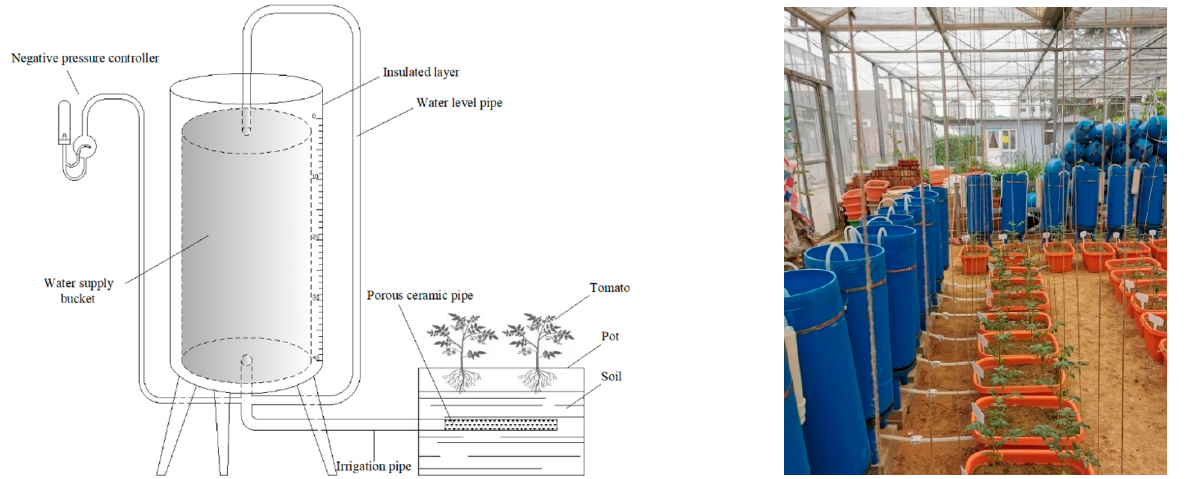
Figure 1. The schematic diagram and physical photo of the negative pressure irrigation